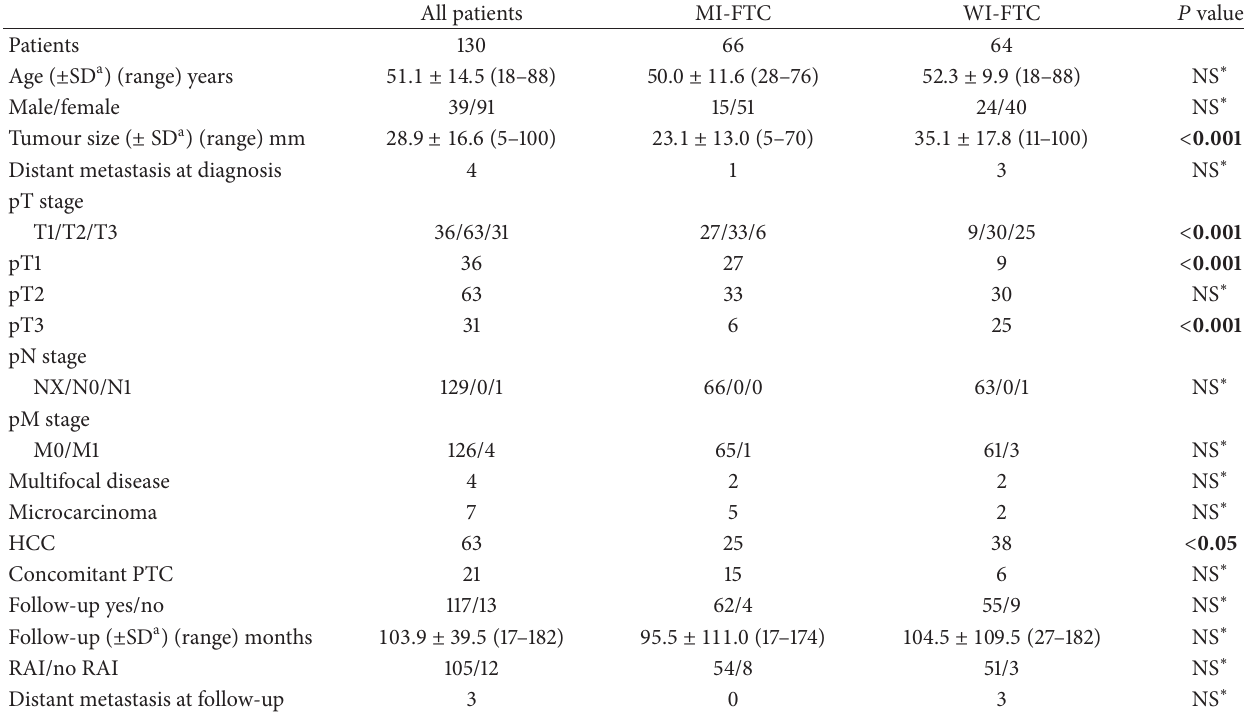
Table 1: Clinical, pathological, and follow-up data of all the included patients. Comparative analysis between MI-FTC and WI-FTC. All